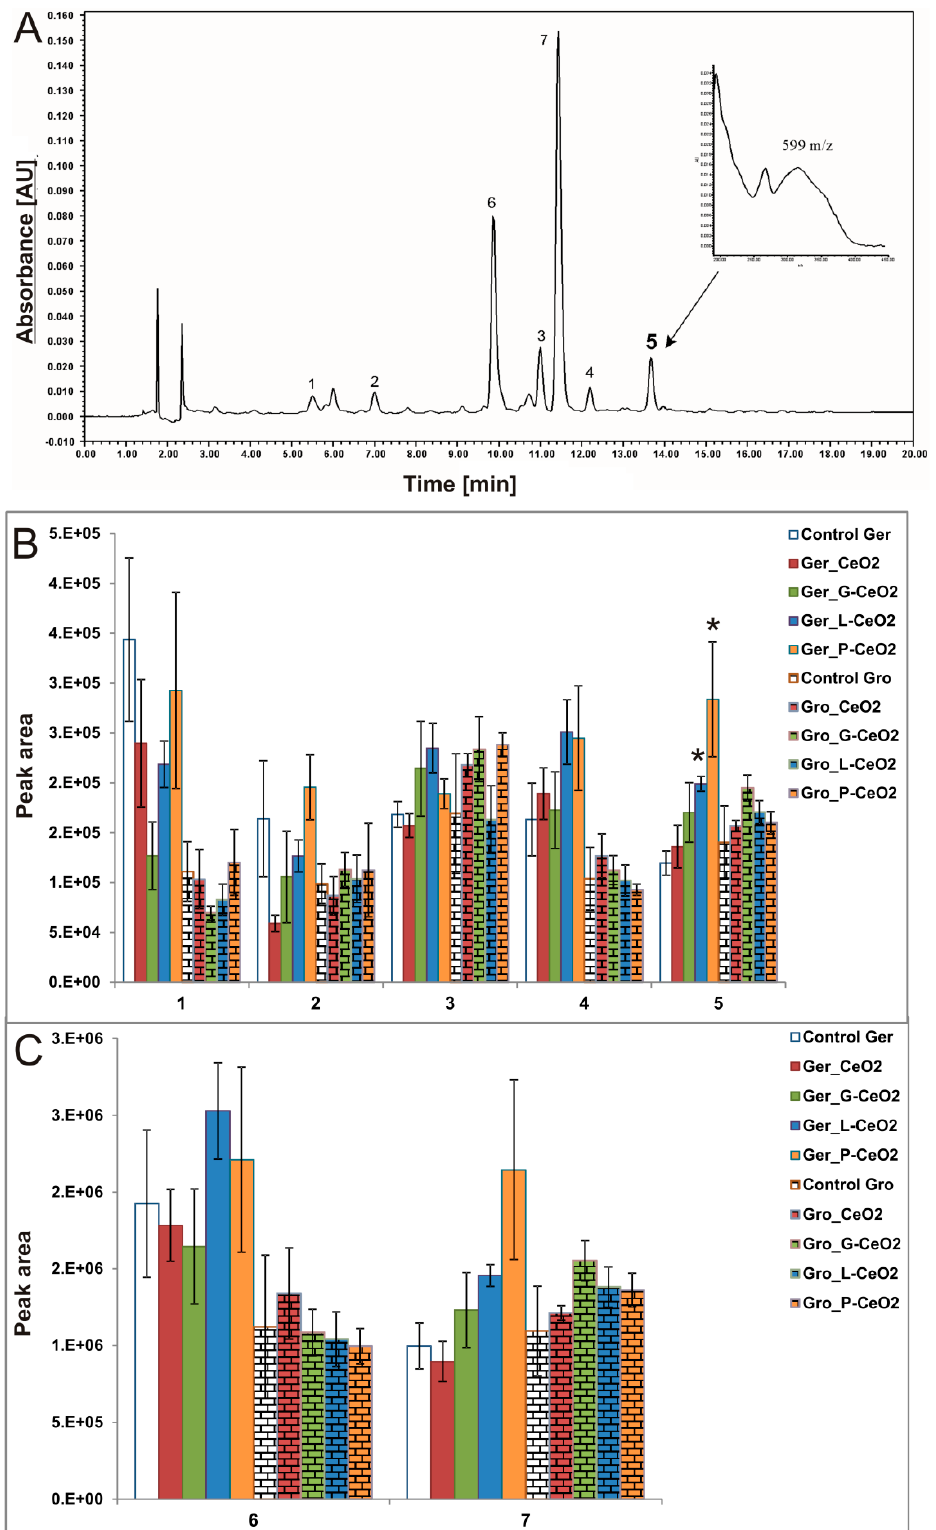
Figure 8. ( A ) HPLC chromatogram of methanolic extracts of pea shoots with UV–Vis spectra of phenolic compounds. ( B ) Unidentified compounds 1–5 and ( C ) unidentified compounds 6 and 7 detected in pea shoots after Ger treatment with different nCeO 2 . Values are shown as mean ± SE; * indicates statistically significant differences in comparison with the corresponding control, p < 0.05.